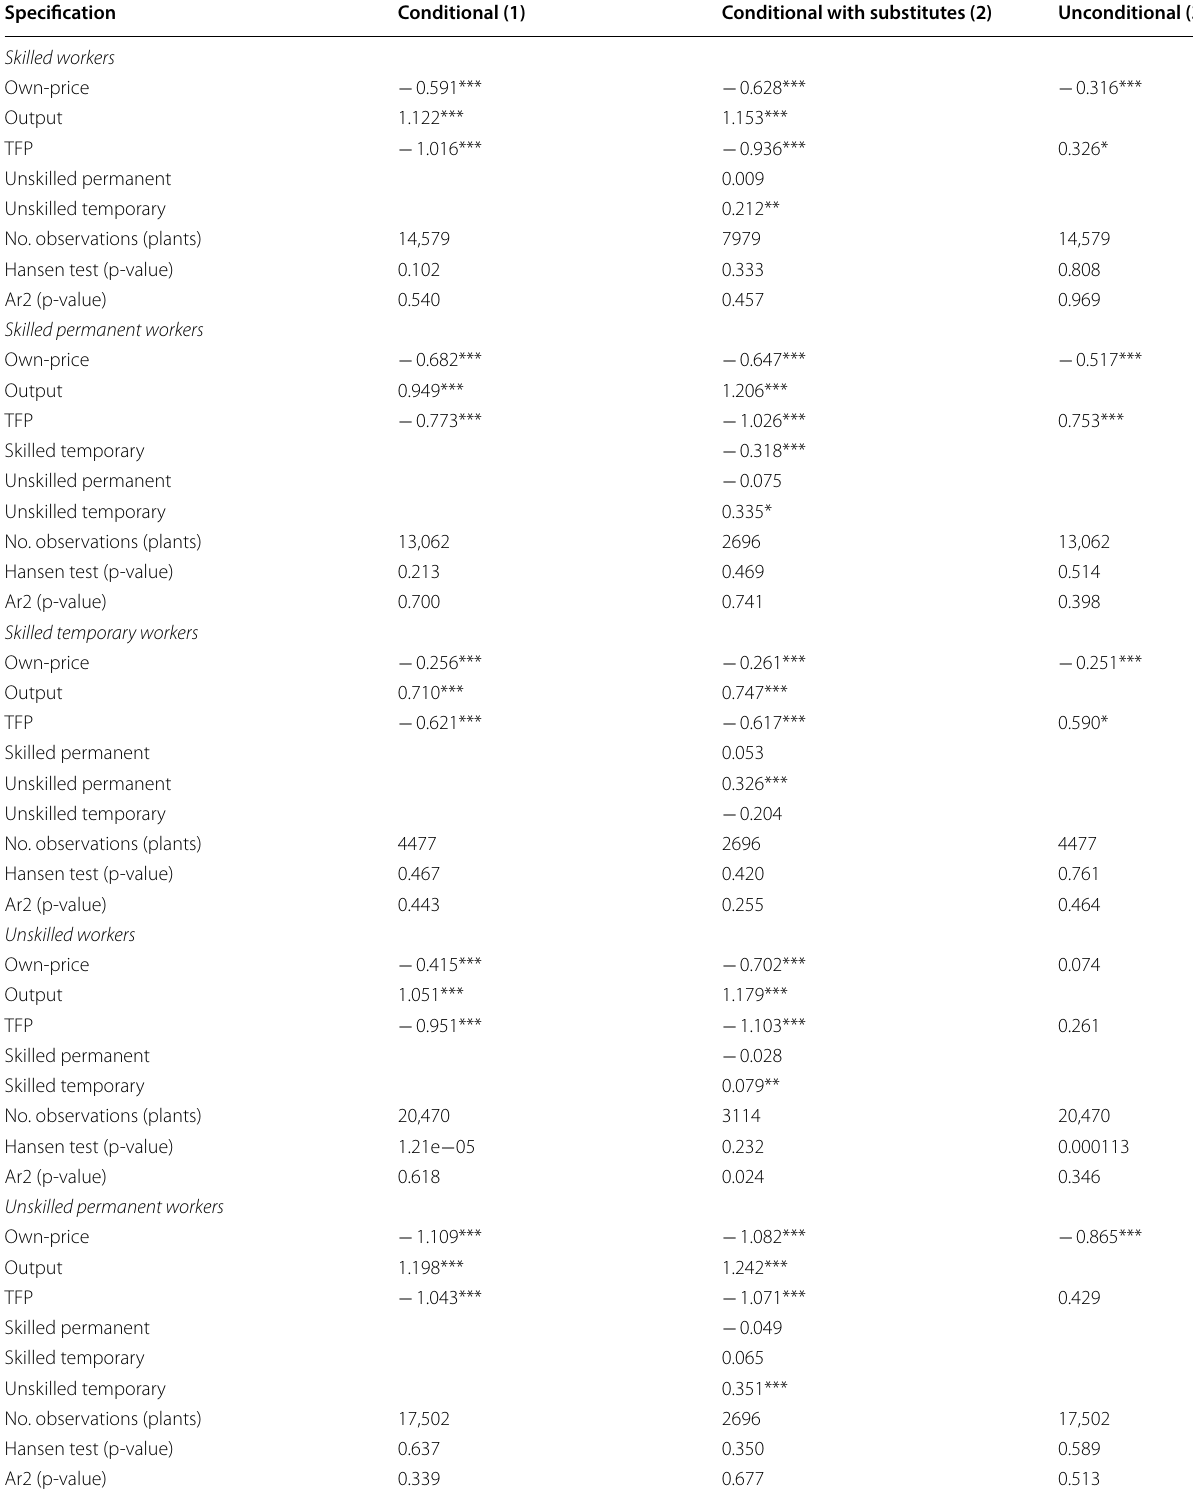
Table 1 Long-run labour demand elasticities (2000–2013). Source Dane-AMS; authors’